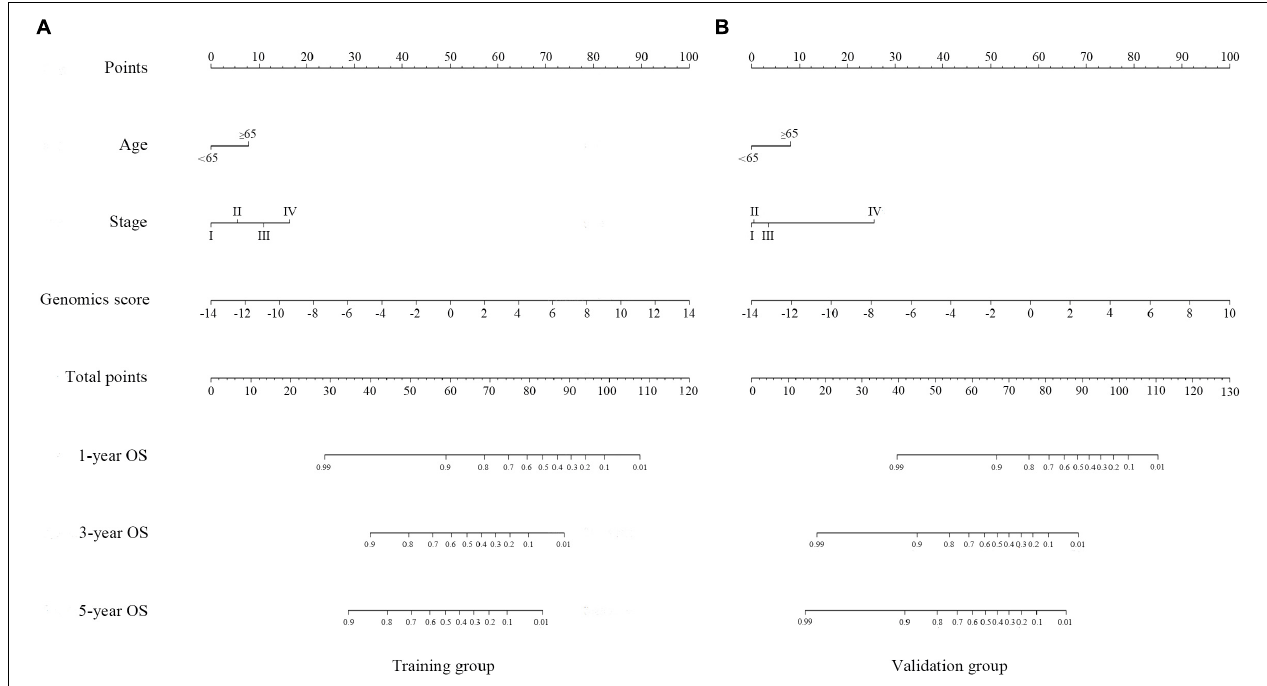
FIGURE 4 | Genomics nomogram to predict the probability of 1-, 3-, and 5-year overall survival (OS) in the training cohort (A) and the validation cohort (B) : to determine how many points for each variable to the probability of OS, locate the variable on its axis, draw a line straight upward to the point axis, repeat this process for each variable, sum up the points achieved for each of the risk factors, locate the final sum on the total point axis, and draw a line straight down to find the patient’s probability of OS.